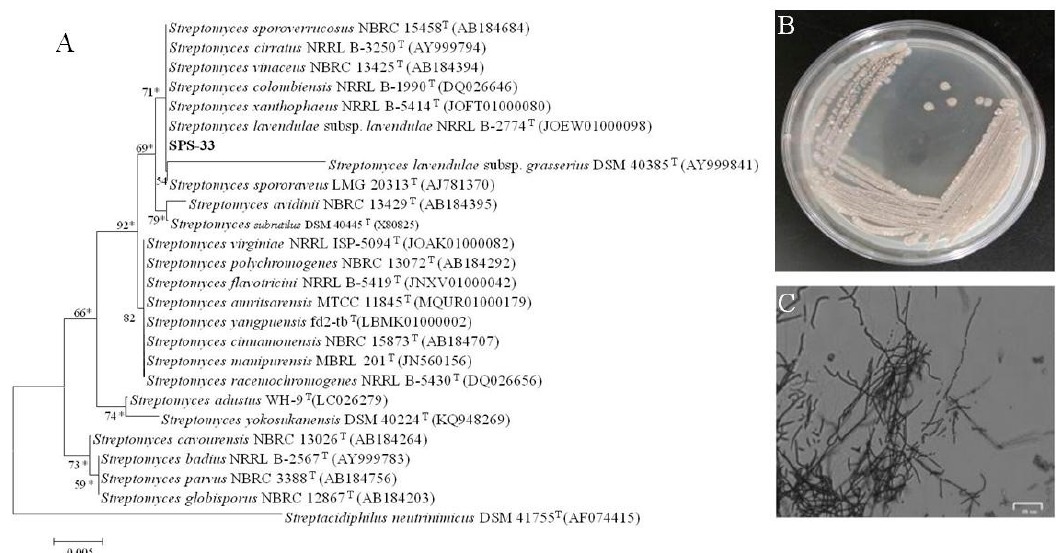
Figure 1. Identification of strain SPS-33. ( A ) The 16S rRNA gene phylogenetic tree constructed by a maximum-likelihood method based on the Kimura 2-parameter model showing the phylogenetic status in the genus Streptomyces . Bootstrap values greater than 50% are given at nodes. Asterisks indicate branches of the tree that were also recovered using maximum parsimony and neighbor-joining analysis of 1000 replications. ( B ) Colony morphology traits of strain SPS-33 was grown on ISP 2 medium agar at 28 °C for 7 days. ( C ) Microscopic morphological characteristics of strain SPS-33 showing the mycelia growth at 28 °C for 7 days on ISP 2 medium agar. Scale bar: 25 μ m.